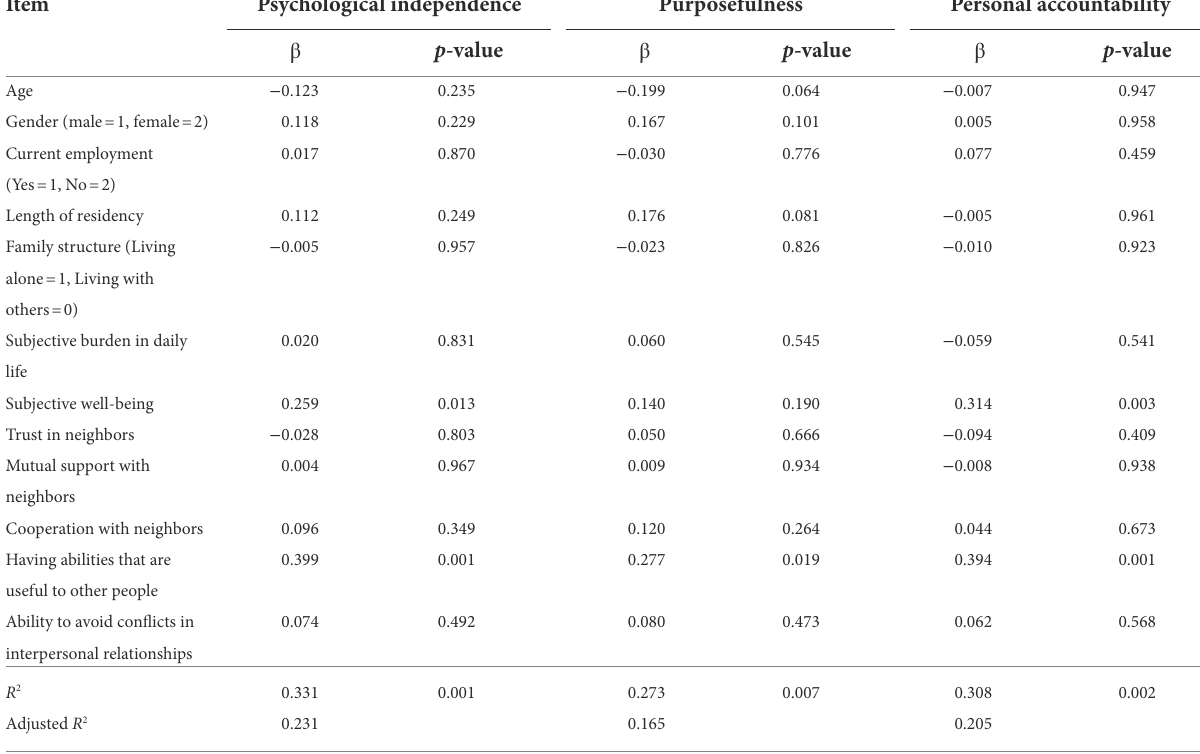
TABLE 3 Factors relating to psychological independence and its